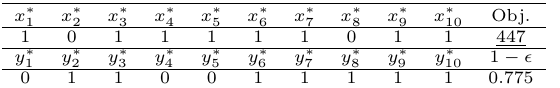
Table 3. Optimal solution for the